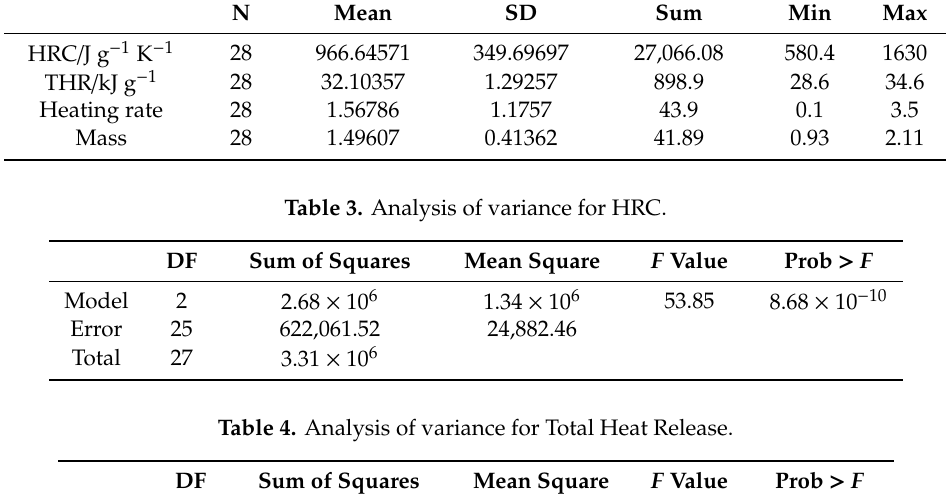
Table 2. Descriptive statistics of experimental data.